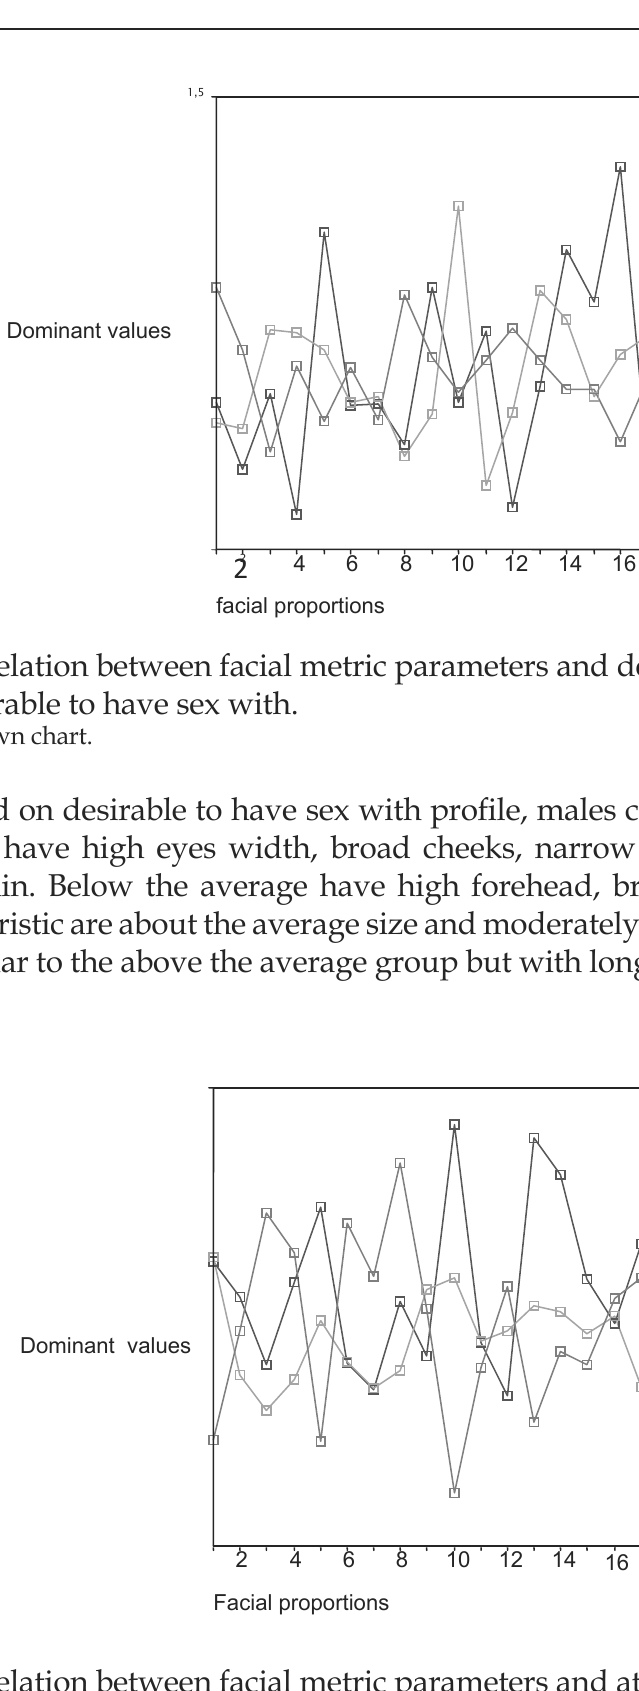
Fig. 5. Relation between facial metric parameters and attractive – not attractive. Source: Own